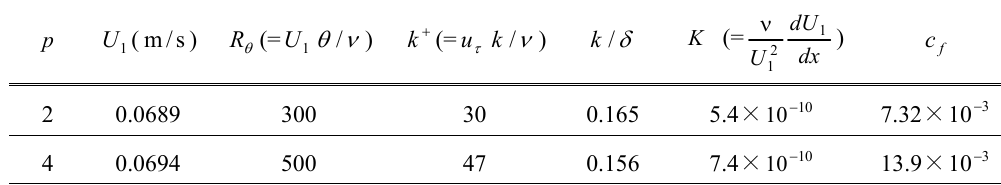
Experimental conditions at x =865 mm